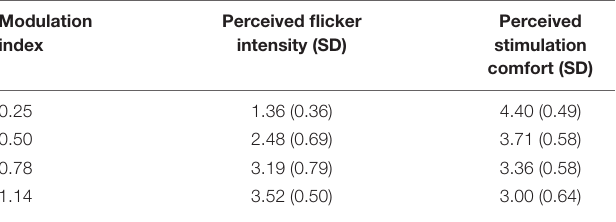
TABLE 1 | User-experience data averaged over participants and frequencies. Modulation